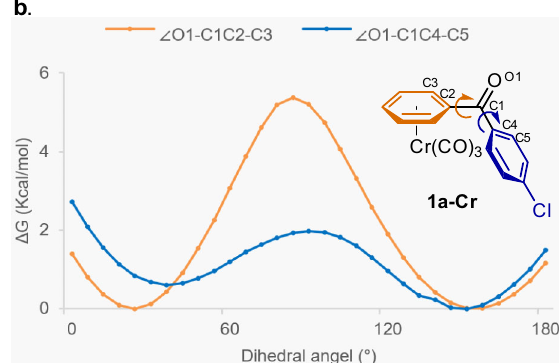
anglebetweenthecarbonylgroupandthearomaticringin 1a . b Energydiagramof a relaxed scan of the dihedral angle between the carbonyl group and the aromatic ring in 1a-Cr .